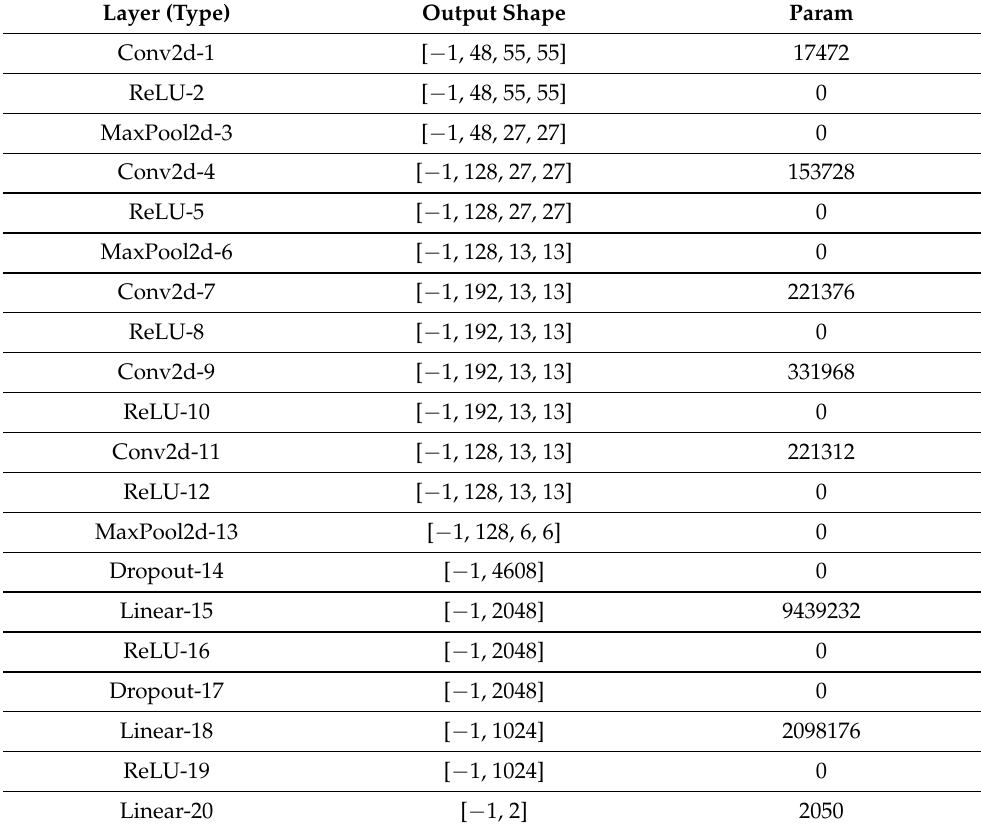
Table 1. JCM-AlexNet model structure and corresponding training